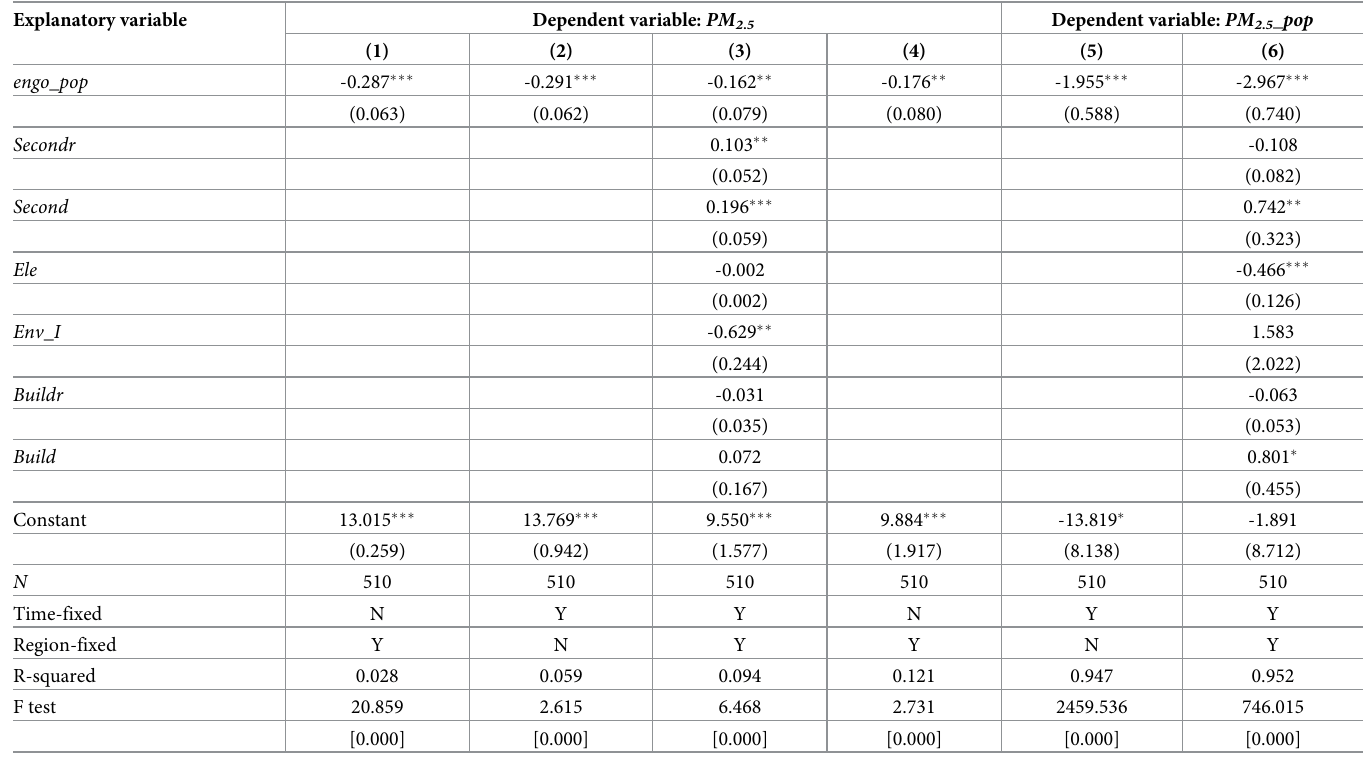
Table 2. PM 2.5 emission reduction effect of